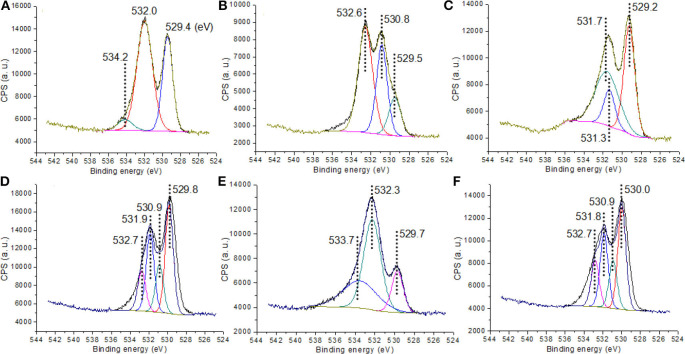
XPS spectra of O 1s region for (A) C1, (B) C2, (C) C3, (D) C4, (E) C1g, and (F) C4g.